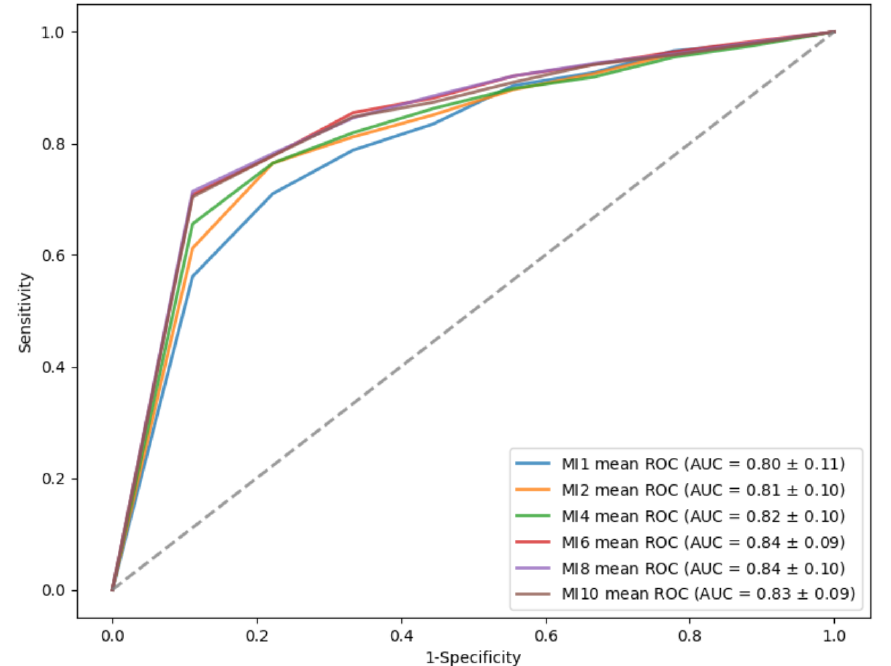
Figure 4. ROC curve of six selected feature subsets in differentiating normal from glaucomatous